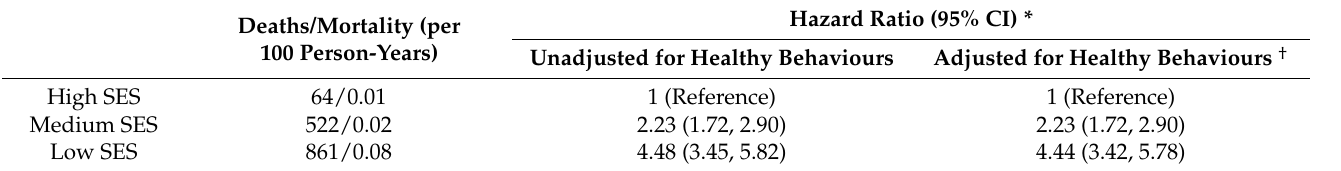
Table 2. Associations of socioeconomic status with total respiratory disease